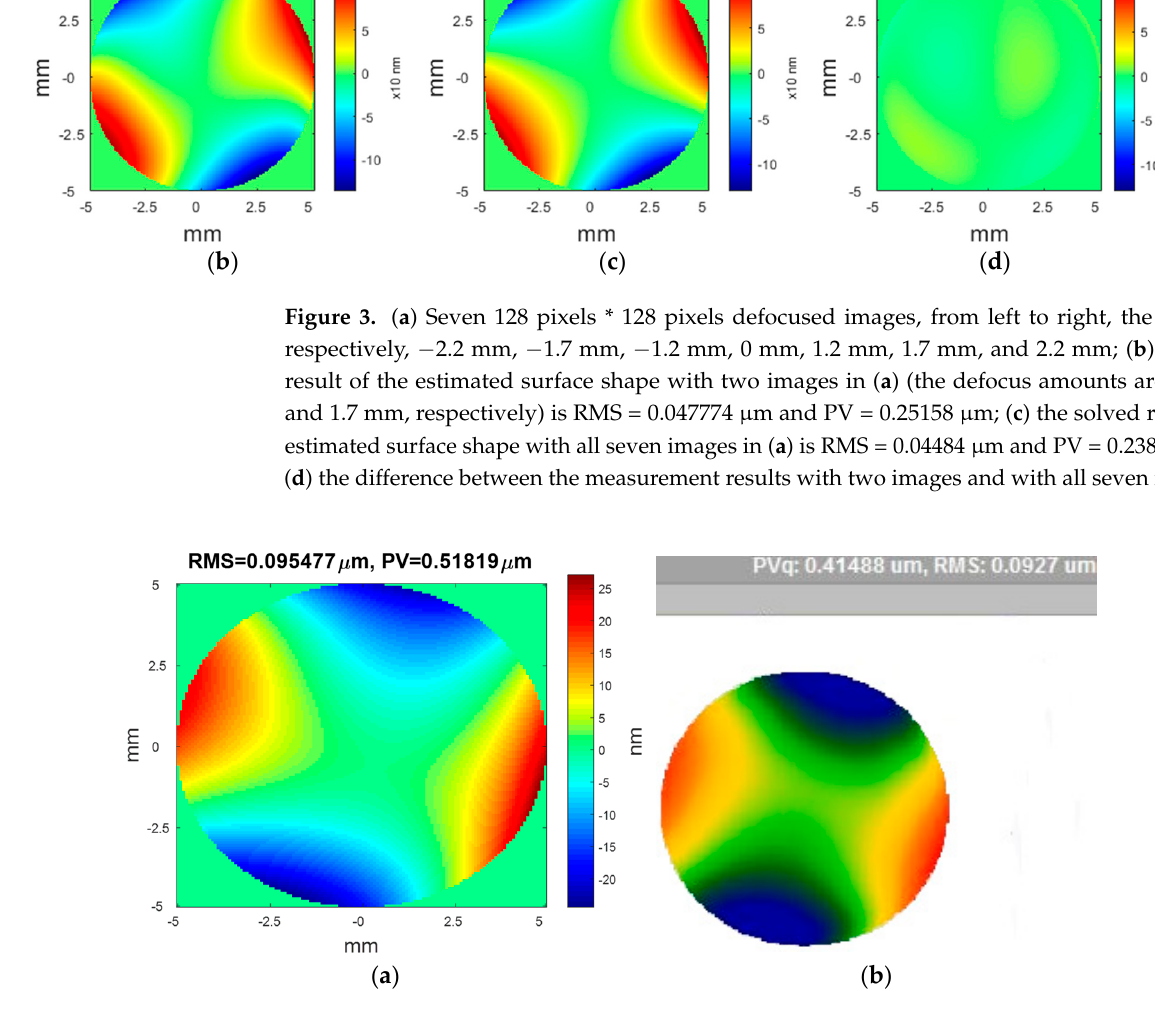
Figure 4. The measurement results with ( a ) PR: RMS = 0.095477 μ m, PV = 0.51819 μ m; ( b ) WYKO: RMS = 0.0927 μ m, PV = 0.41488 μ m.